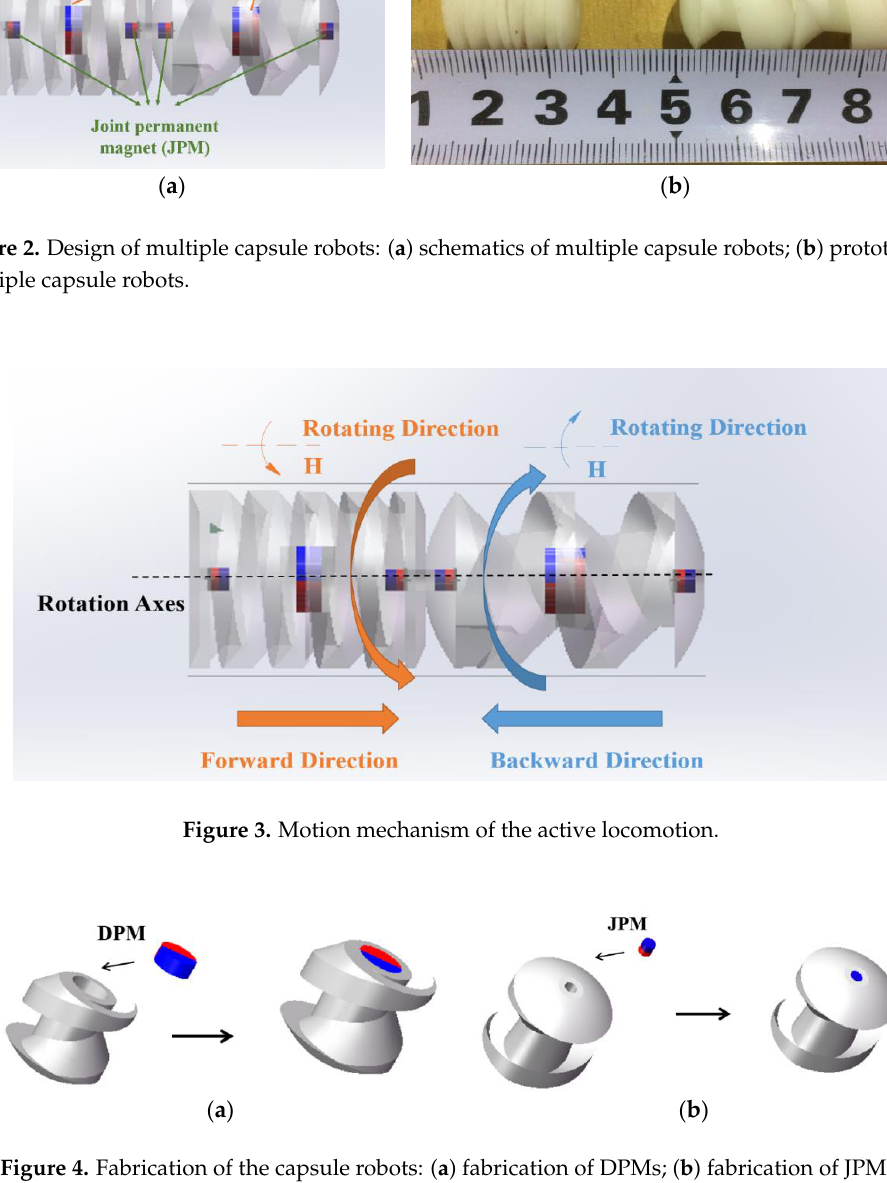
Figure 4. Fabrication of the capsule robots: ( a ) fabrication of DPMs; ( b ) fabrication of JPMs. Table 1. Parameters of the two capsule robots. Table 1. Parameters of the two capsule